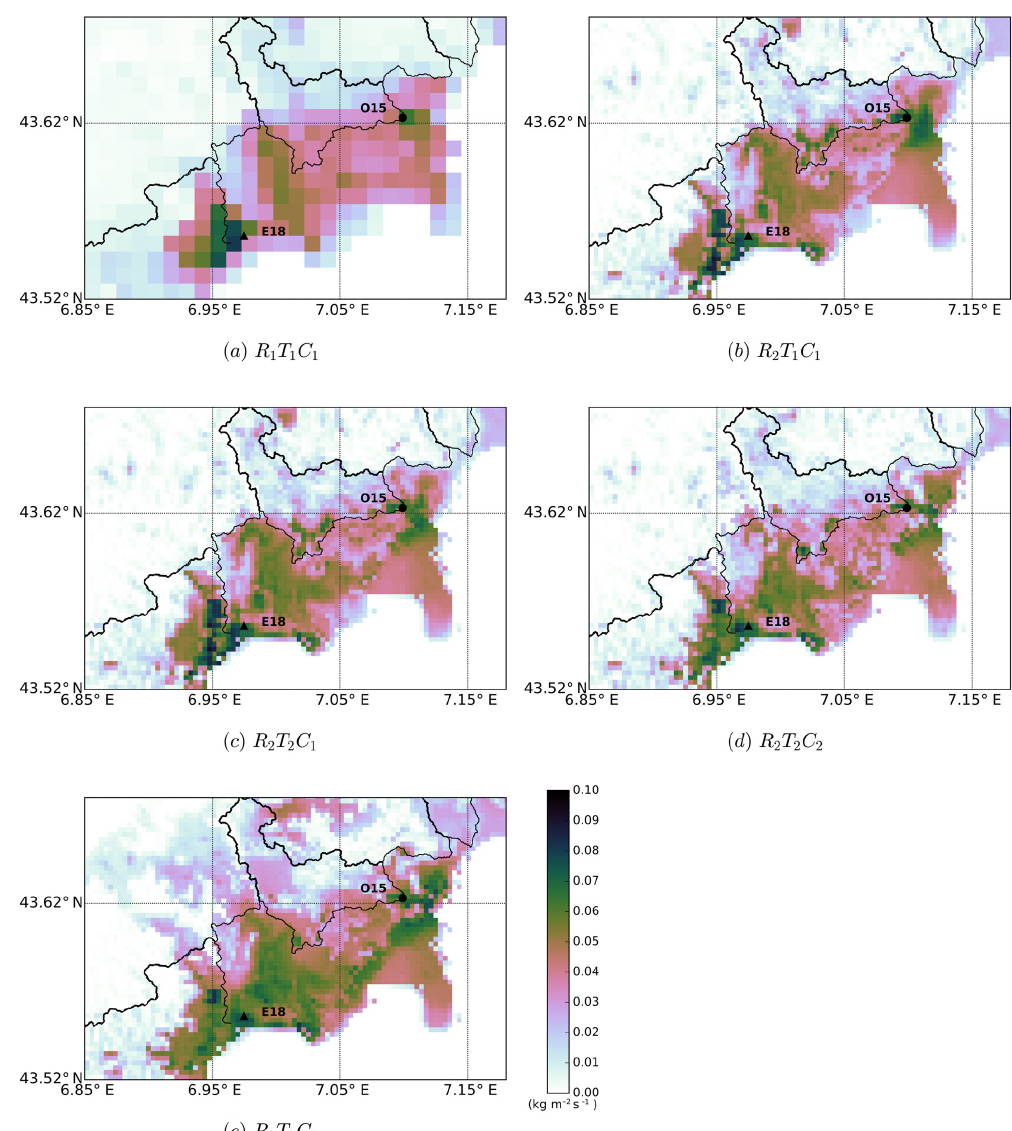
Figure 9. Cumulated runoff for each experiment for the October 2015